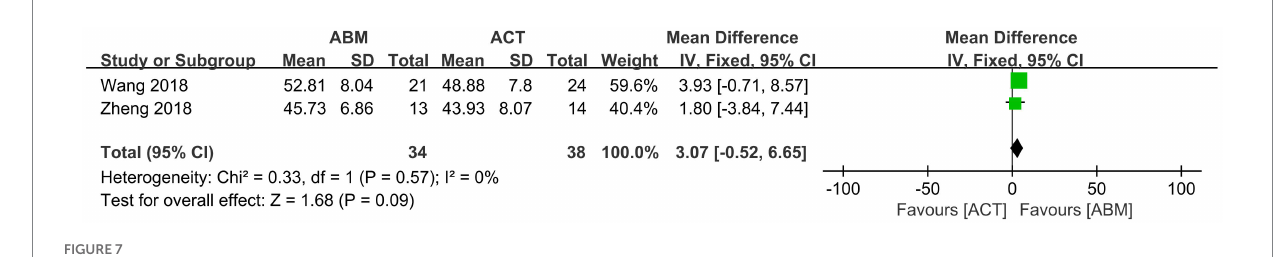
FIGURE 7 Forest plot of attention control outcome in comparison with ABM versus